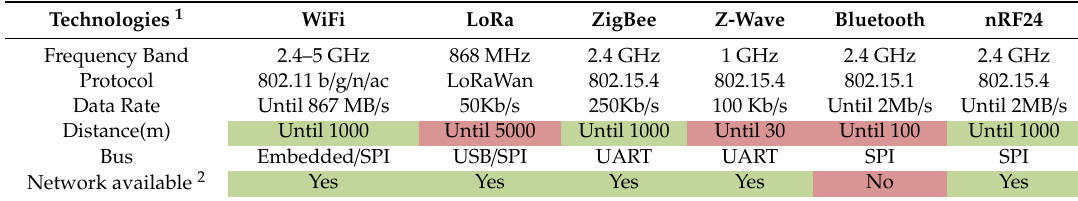
Table 1. Comparison between di ff erent communication technologies.